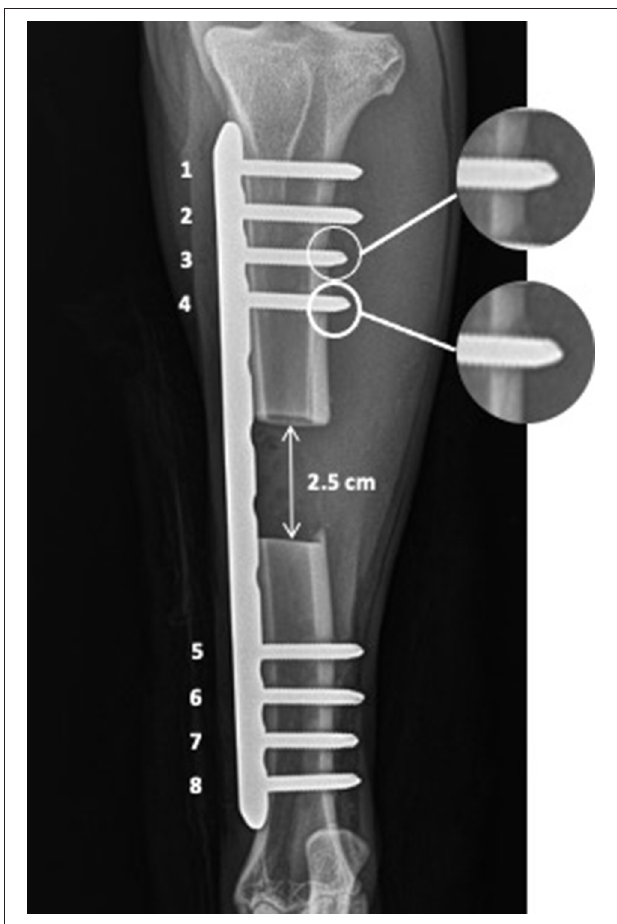
FIGURE 1 | The 2.5cm osteotomy was stabilized with 8-hole, 4.5mm thick locking plate and eight 4.0mm locking-head screws, four in the proximal bone segment in positions from 1 to 4 and four in the distal bone segment in the positions from 5 to 8. The transcortical diaphyseal fractures are marked with the white circle and enlarged on the right side of the